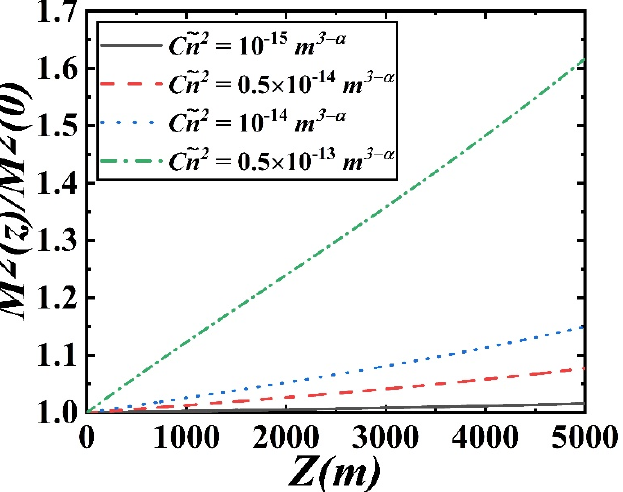
Figure 5. Dimensionless quantity M 2 ( z ) / M 2 ( 0 ) of a partially coherent Airy beam in non-Kolmogorov turbulence versus propagation distance for different (cid:101) C 2 n .